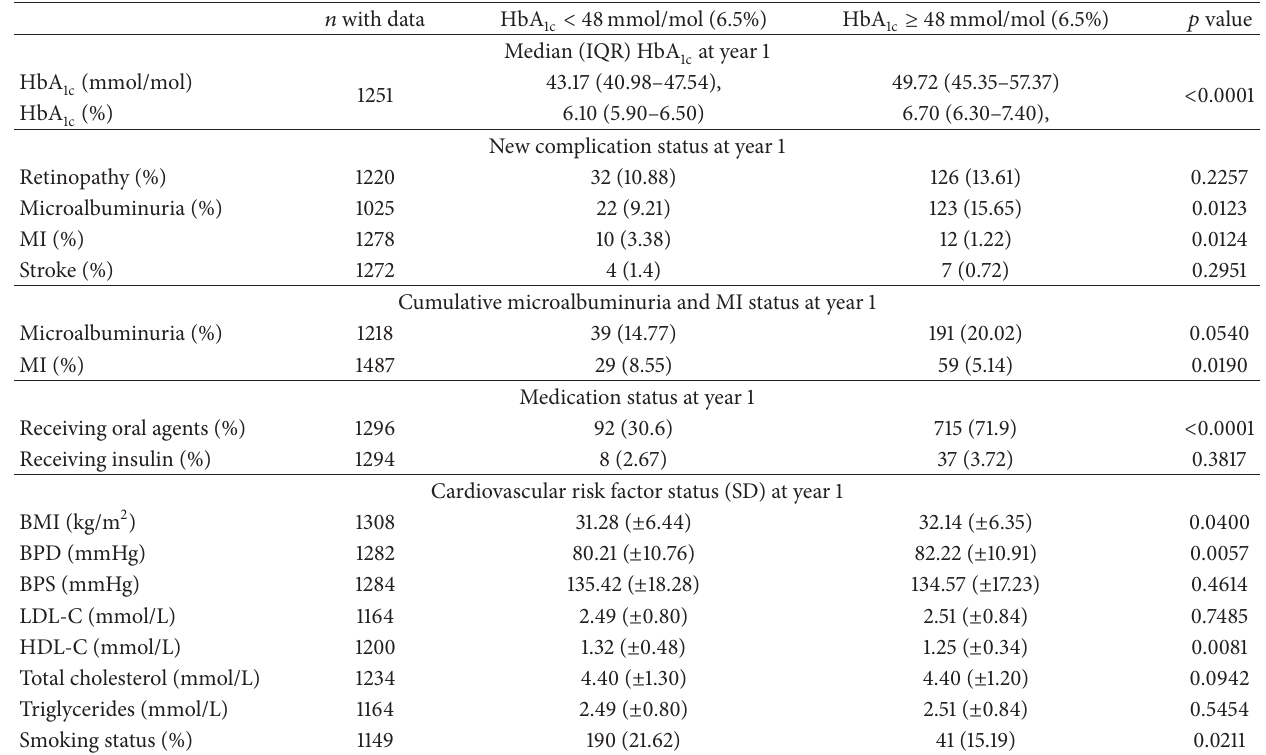
Table 3: Prospective comparisons between participants diagnosed with HbA 48 mmol/mol at year